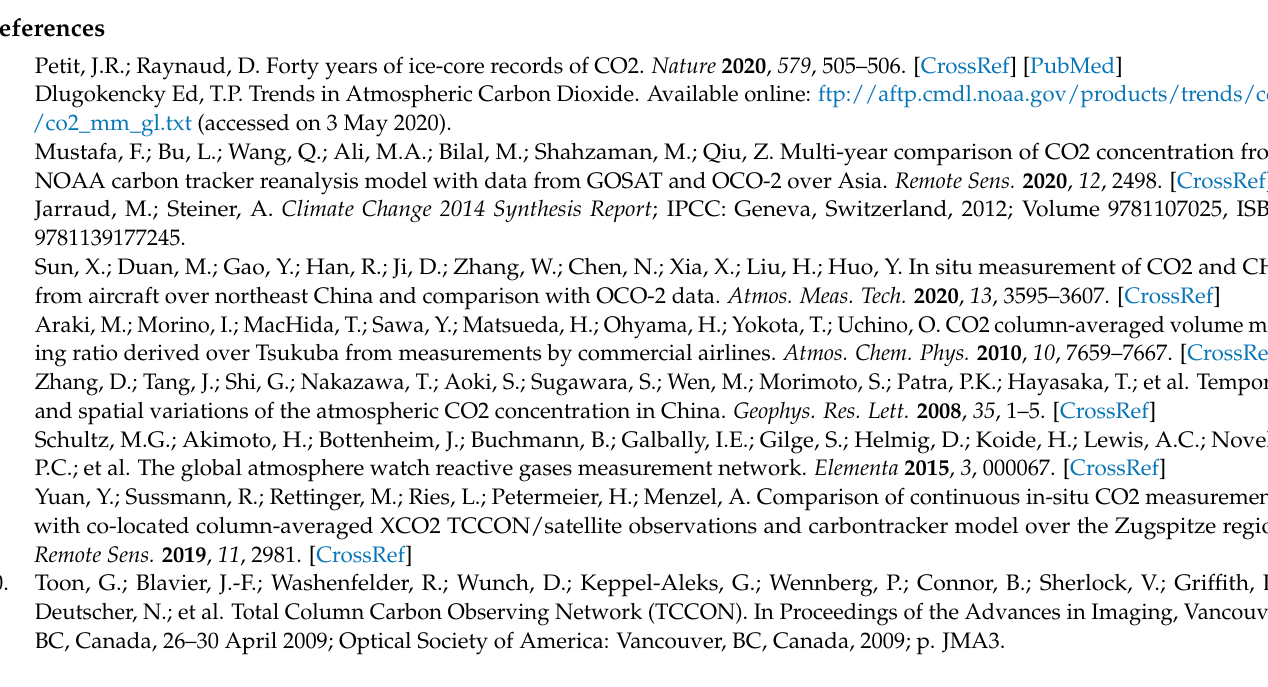
Figure A5. The flight trajectory on 14 March ( left ) and 19 March ( right ) 2019 over Qinhuangdao, China. The color bar represents the progression of time, where blue represents the starting time and red represents the ending time.